Question: In one sentence, what is this figure communicating?
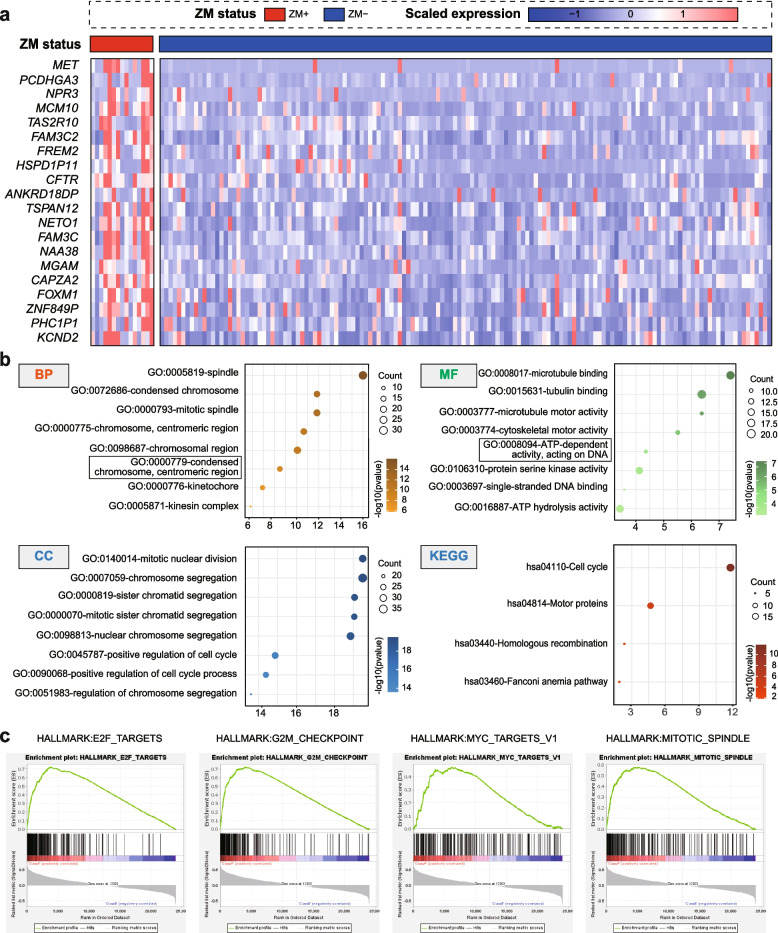
Answer: Transcriptomic profiling identifies a distinct molecular signature in ZM-positive tumors. a Heatmap of the top 20 upregulated genes in ZM-positive tumors. Gene expression was z-score normalized across samples. The top annotation bar indicates ZM fusion status, with red representing ZM-positive tumors and blue representing ZM-negative tumors. In the heatmap, red and blue indicate higher and lower relative expression, respectively. b Gene Ontology (GO) and Kyoto Encyclopedia of Genes and Genomes (KEGG) enrichment summary of the 359 upregulated genes in ZM-positive tumors. Enrichment results are shown for biological process (BP), molecular function (MF), cellular component (CC), and KEGG pathways. Dot size indicates the number of enriched genes, and dot color indicates − log10(P value). c Gene Set Enrichment Analysis (GSEA) showing representative hallmark gene sets enriched in ZM-positive tumors, including E2F targets, G2M checkpoint, MYC targets V1, and mitotic spindle. Green curves indicate running enrichment scores, and black vertical lines indicate the positions of genes from each gene set within the ranked gene list